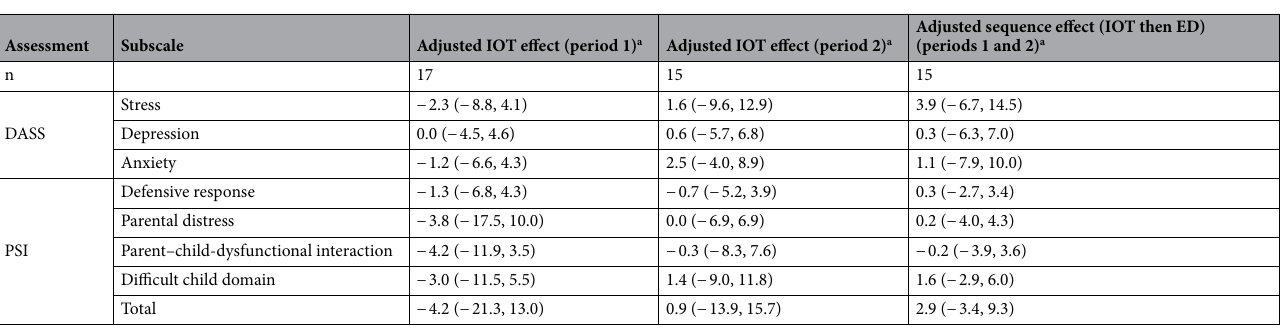
Table 3. Adjusted mean difference between arms, following the first and second study period and overall. IOT insight oriented psychotherapy, ED education. a Beta coefficient for the between group difference (IOT arm relative to education arm) from a linear regression model, using an ANCOVA framework, adjusted for parents age, duration of grief, gender, and the (baseline) measure at the start of the period being analysed.